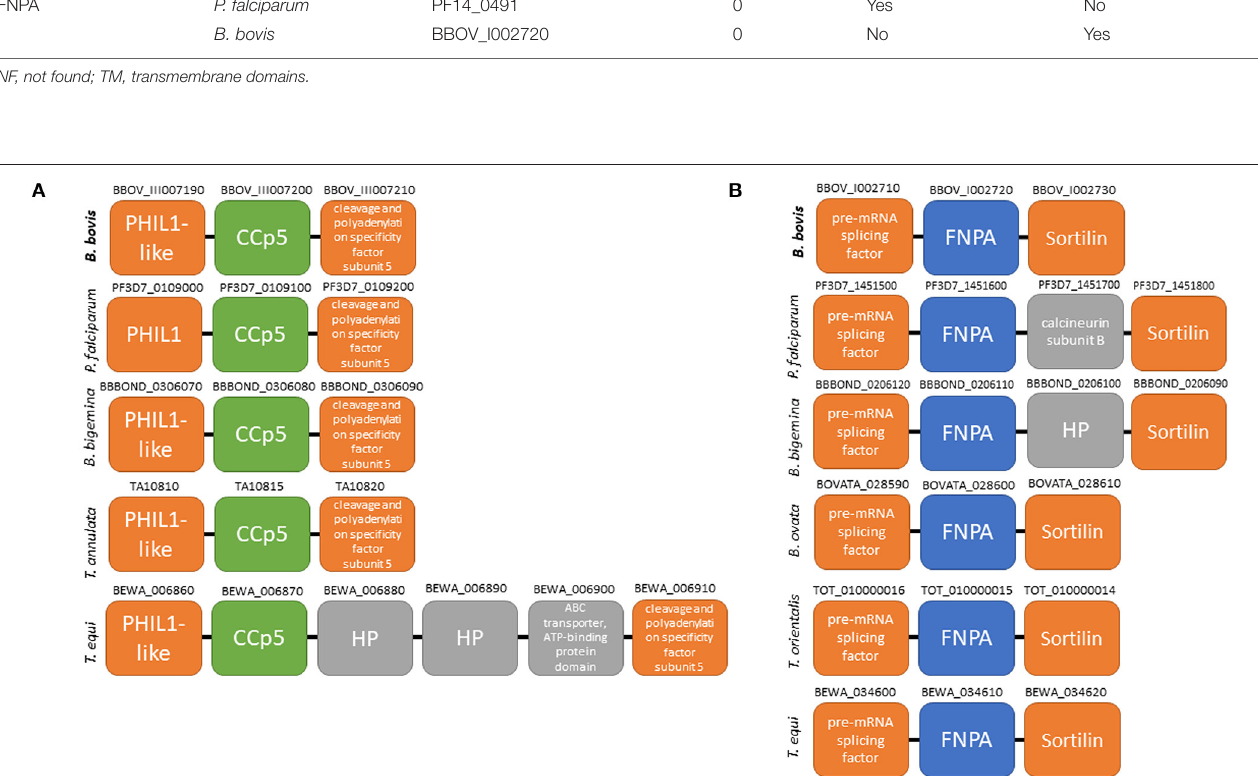
TABLE 2 | Predicted features of the B. bovis CCp5 and FNPA genes. Gene Chromosome Gene